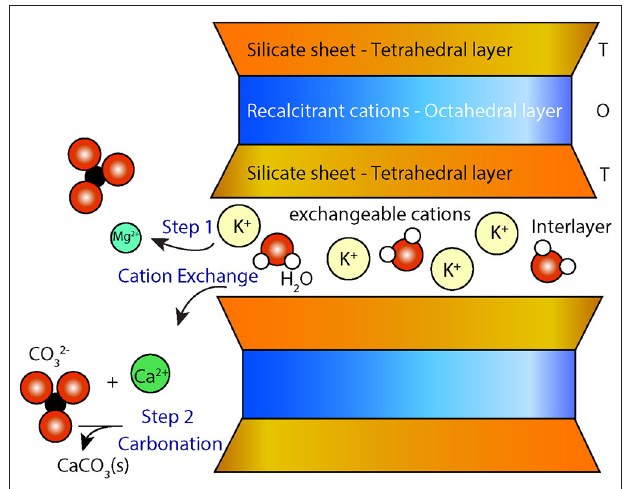
FIGURE 1 | Conceptual diagram showing cation exchange between the interlayer of smectites and a solution that is saturated with a potassium salt (e.g., KCl). Divalent cations (Mg 2 + and Ca 2 + ) are exchanged with K + in the interlayer space of the smectite (step 1) making them available for carbonation (step 2). T-O-T represents the layered configuration of smectite with an octahedral layer (O) between two tetrahedral silicate layers